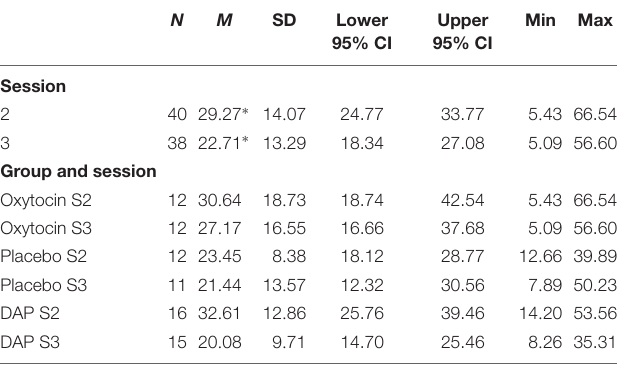
TABLE 9 | Mean concentration of plasma oxytocin (pg/ml) in each session and in each treatment group separated by session.